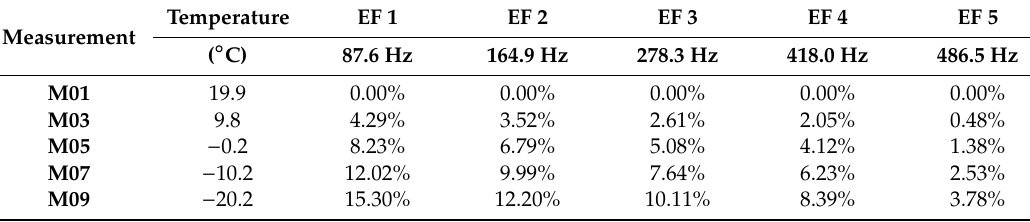
Figure 5. Response spectra of measurements conducted at different temperatures. Table 2. Relative shift of the first five natural frequencies (EF 1 to EF 5) under different temperatures; the values are peak estimates of the averaged response spectra.